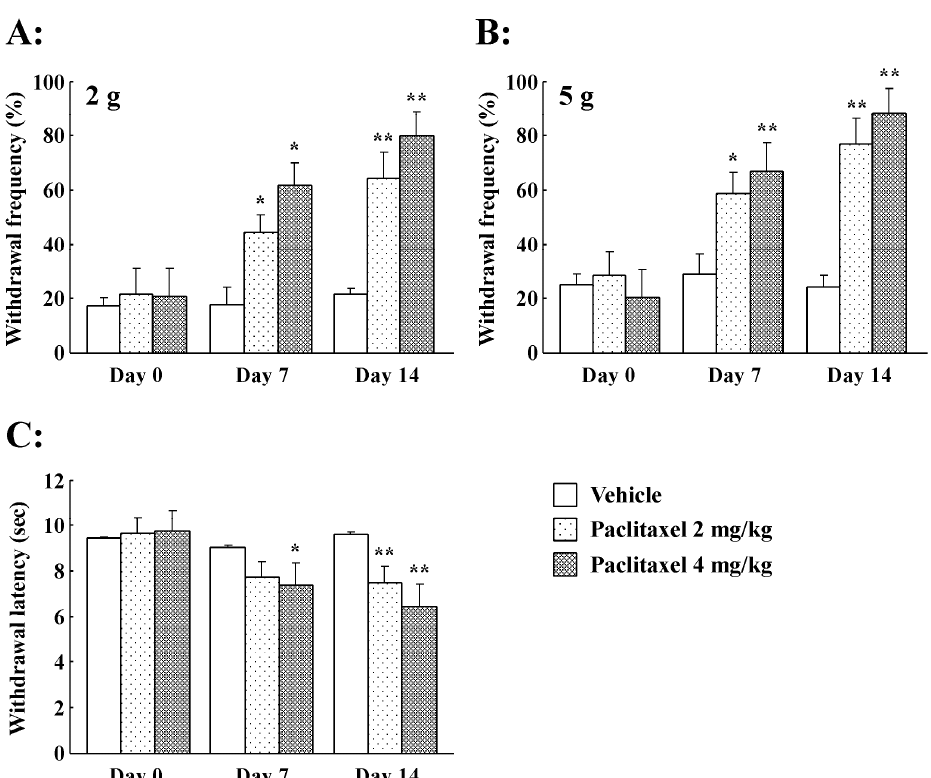
Figure 1. Paclitaxel (2 and 4 mg / kg, i.p.)-induced mechanical allodynia / hyperalgesia and thermal hyperalgesia as determined by the von Frey test and paw thermal stimulation test, respectively. ( A ) von Frey filaments (2 g) and ( B ) von Frey filaments (5 g) were used to measure mechanical allodynia / hyperalgesia induced by paclitaxel treatment (administered on days 0, 2, 4, and 6) in rats. Histograms show the withdrawal frequency on days 7 and 14 after the start of paclitaxel or Cremophor ® vehicle treatment. ( C ) The paw thermal stimulation test was used to measure thermal hyperalgesia induced by paclitaxel treatment in rats. Histograms show the withdrawal latency at days 7 and 14 after the start of paclitaxel and Cremophor ® vehicle treatment. Data are the mean ± standard error of the mean (SEM) of n = 5–6 rats. * p < 0.05, ** p < 0.01 from vehicle treatment group.